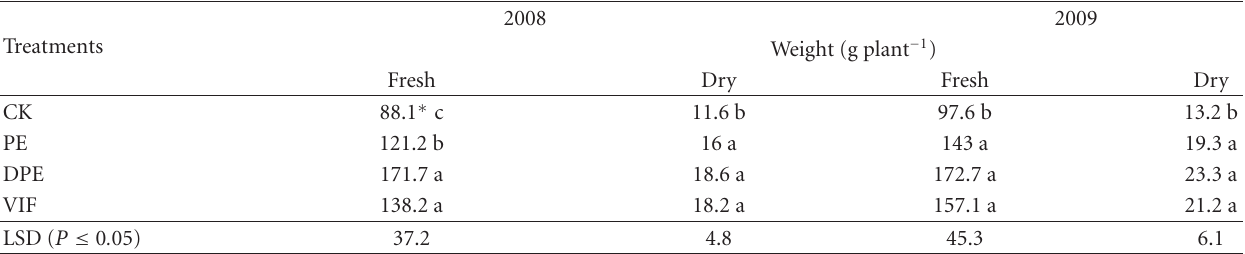
Table 4: E ff ect of solarization with regular polyethylene (PE), double regular polyethylene (DPE), and virtually impermeable films (VIF) on tomato plant fresh and dry weights (g plant − 1 ).